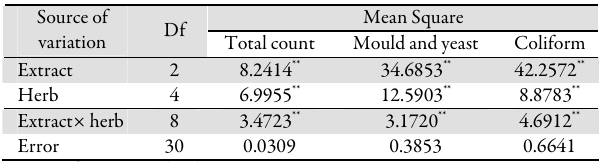
Tab. 3. Variance analysis of the microbial load of the studied medicinal plants